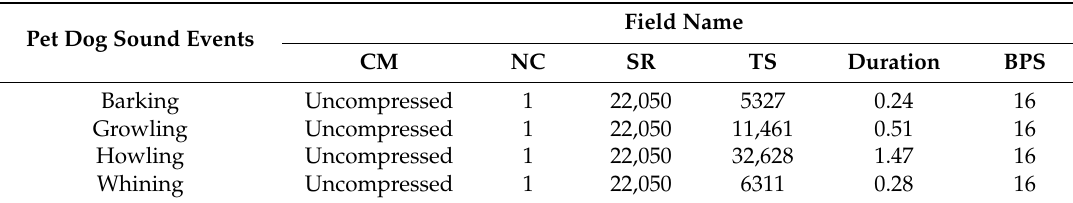
Table 1. Information on pet dog sound data file format.